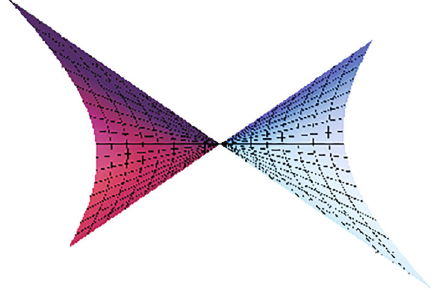
Figure 3: Time-like Plücker